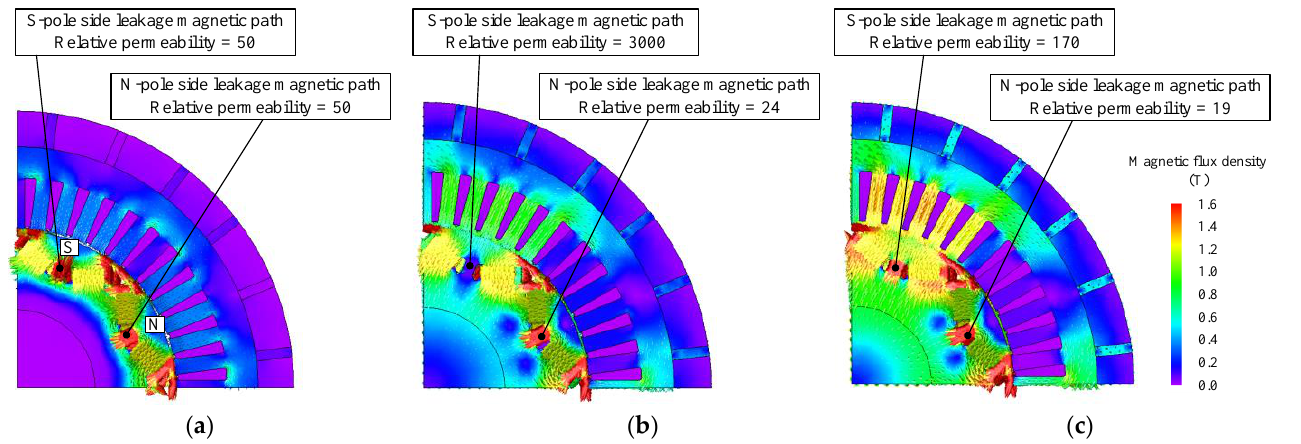
Figure 6. Vector plot of magnetic flux density: ( a ) PM flux without F m ; ( b ) PM and modulation flux with F m of 720 AT; ( c ) PM and modulation flux with F m of 1200 AT.